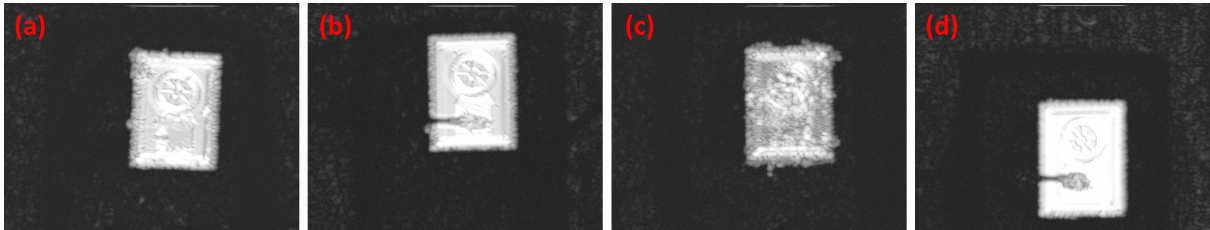
Figure 9. En face scans of four different non-overmoulded FOTs all at different positions. ( a ) Sample 4. ( b ) Sample 6. ( c ) Sample 7. ( d ) Sample